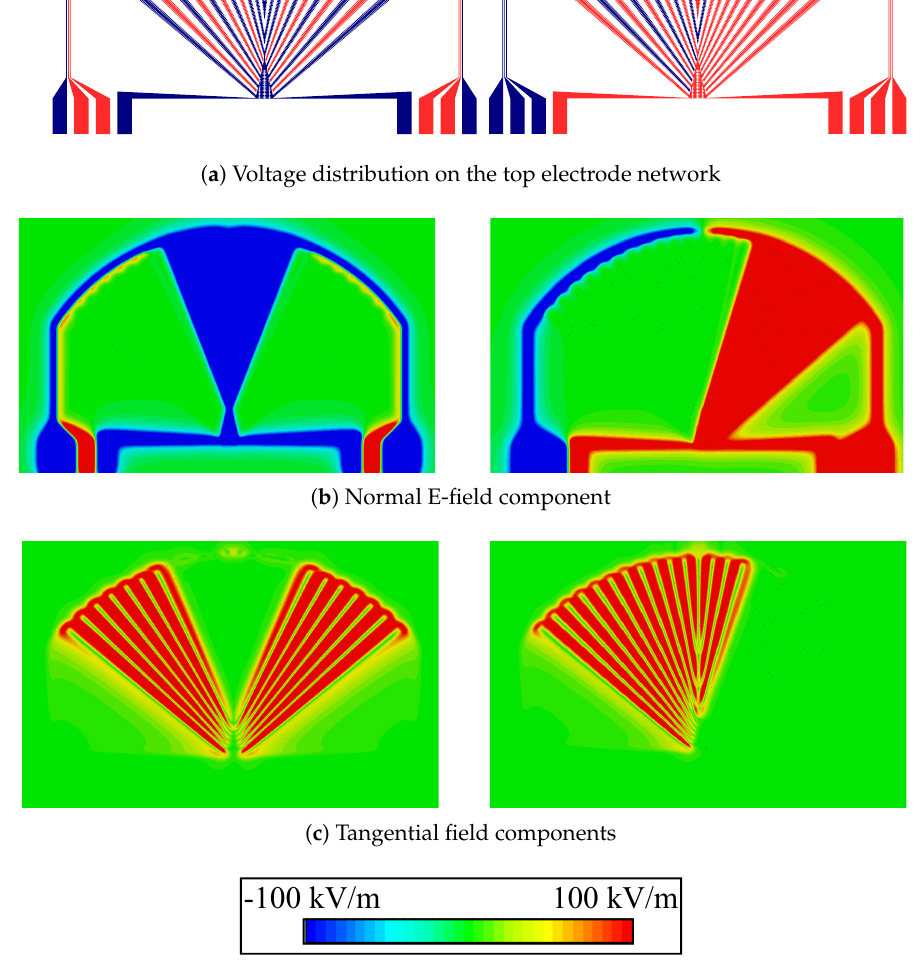
Figure 42. ( a ) The voltage distribution on the electrode network results in different bias field distributions in the LC filled cavity, leading to components responsible for high permittivity ( b ) and low permittivity ( c ). Note the ladder-like stepped impedance structure of the electrodes. [45], reprinted with kind permission of